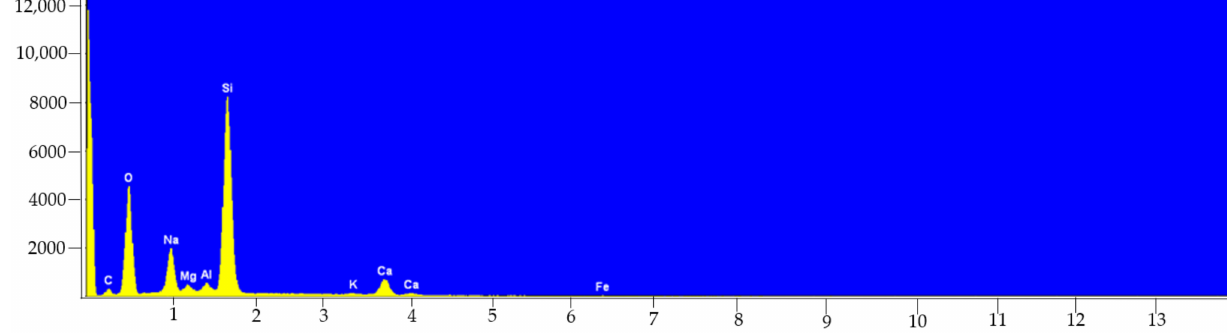
Figure 1. EDS spectrum collected from the surface of glass bottle sample ( ×